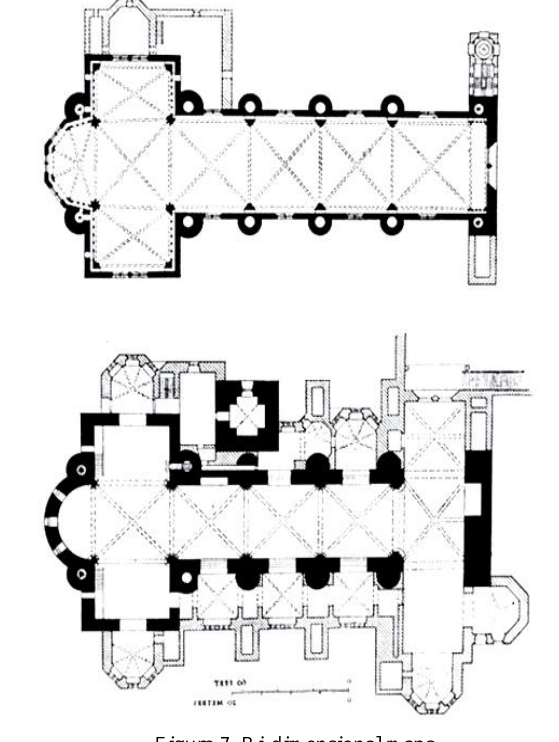
Figure 7. Bi-dimensional maps